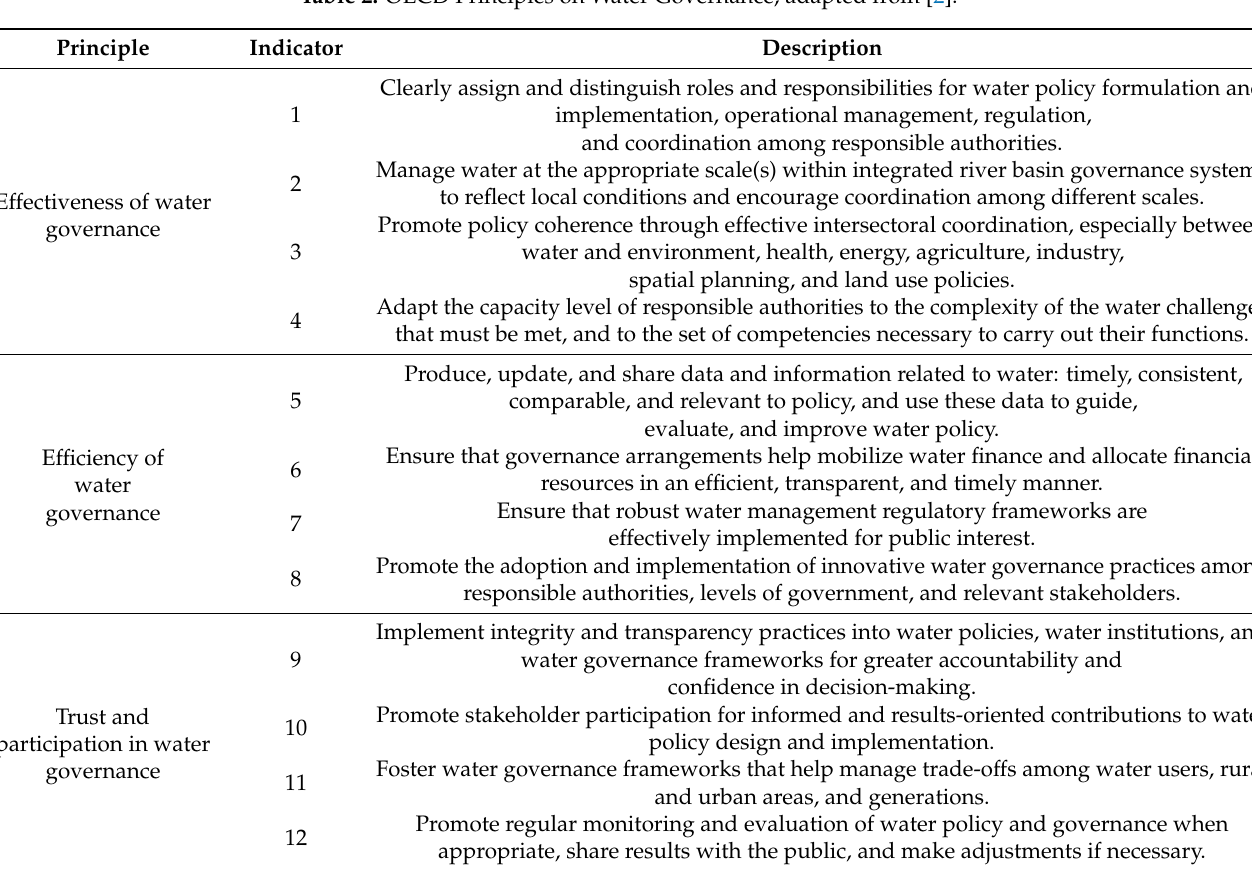
Table 2. OECD Principles on Water Governance, adapted from